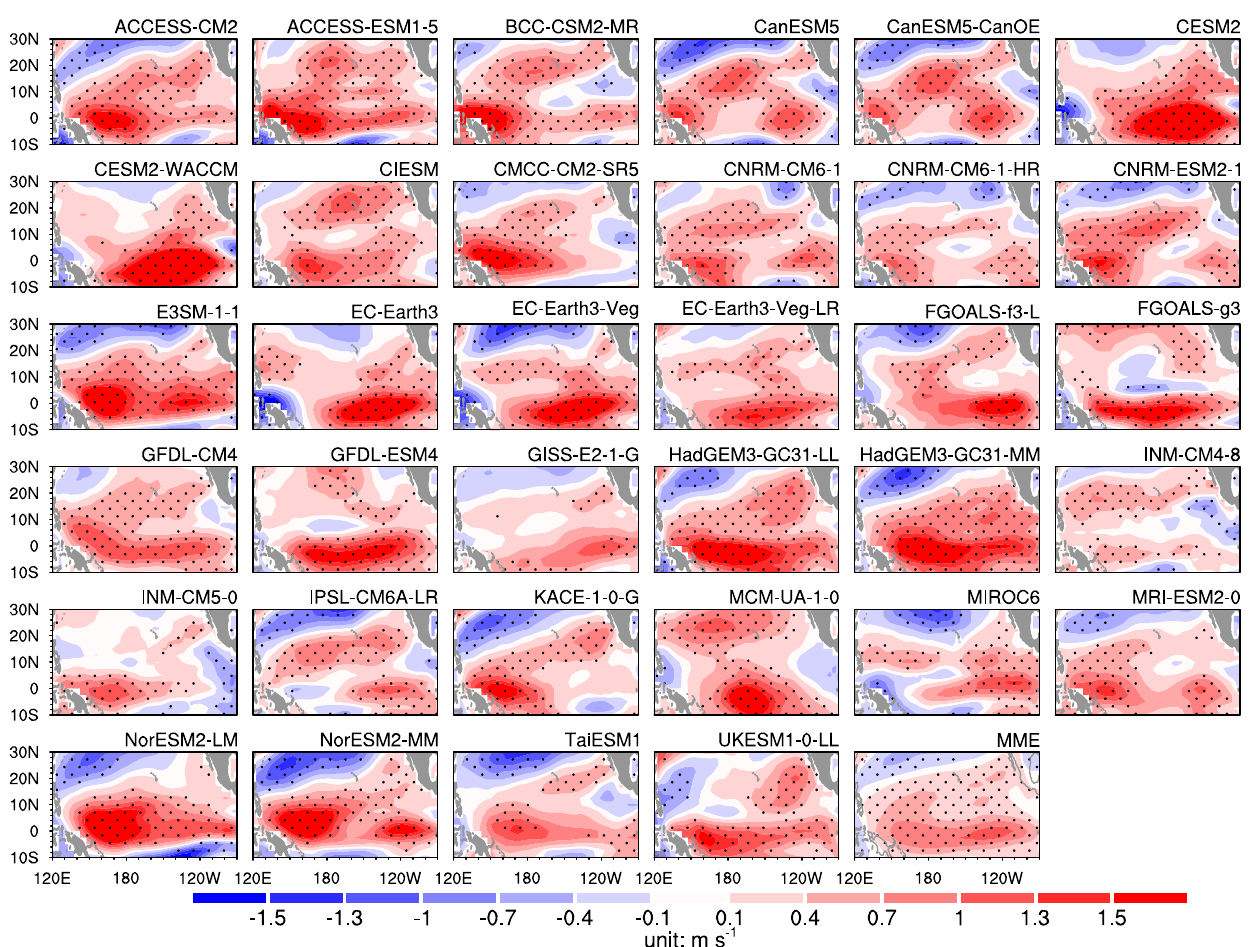
Fig. 8 Change in the mean state of low-level zonal wind under global warming in CMIP6. Differences in the background mean spring 850- hPa zonal wind between present-day climate period (historical simulations over 1920 – 1999) and future climate period (SSP-585 simulations over 2020 – 2099) for 34 CMIP6 models (Supplementary Table 2) and their MME. Stippling regions indicate the differences that are signi fi cantly different from zero at the 95% con fi dence